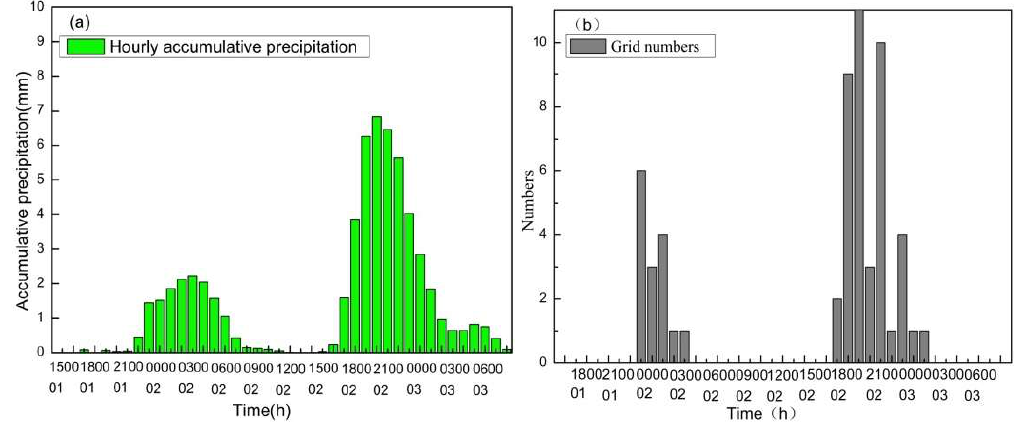
Figure 1. Temporal evolution of area-mean hourly precipitation in mm ( a ) and the number of grids with a cumulative precipitation in one hour of over 20 mm ( b ) in the precipitation zone (30.25 ◦ N–31.55 ◦ N, 106.05 ◦ E–108.05 ◦ E).